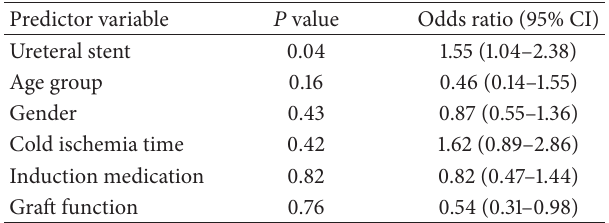
Table 2: Logistic model for viremia.